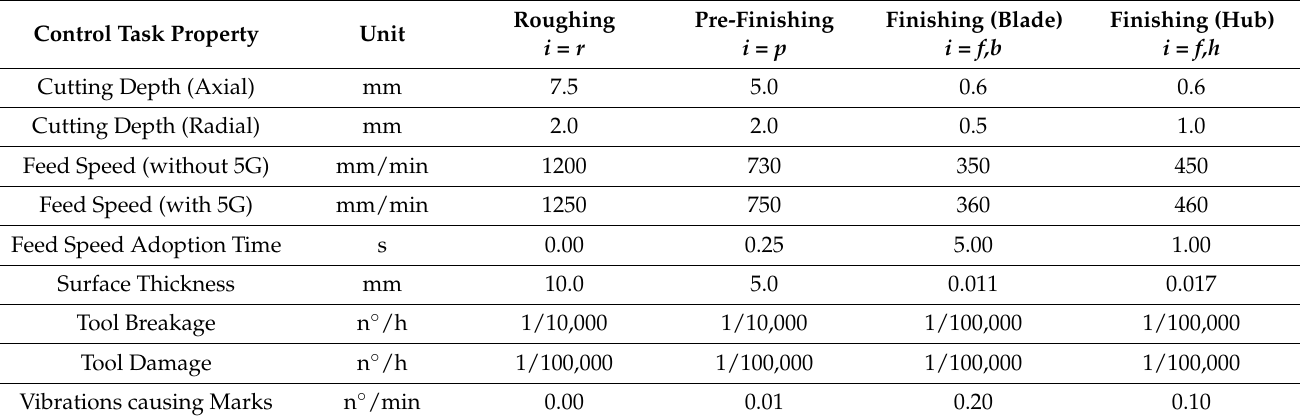
Table 7. Case study values for control tasks of milling machine producing